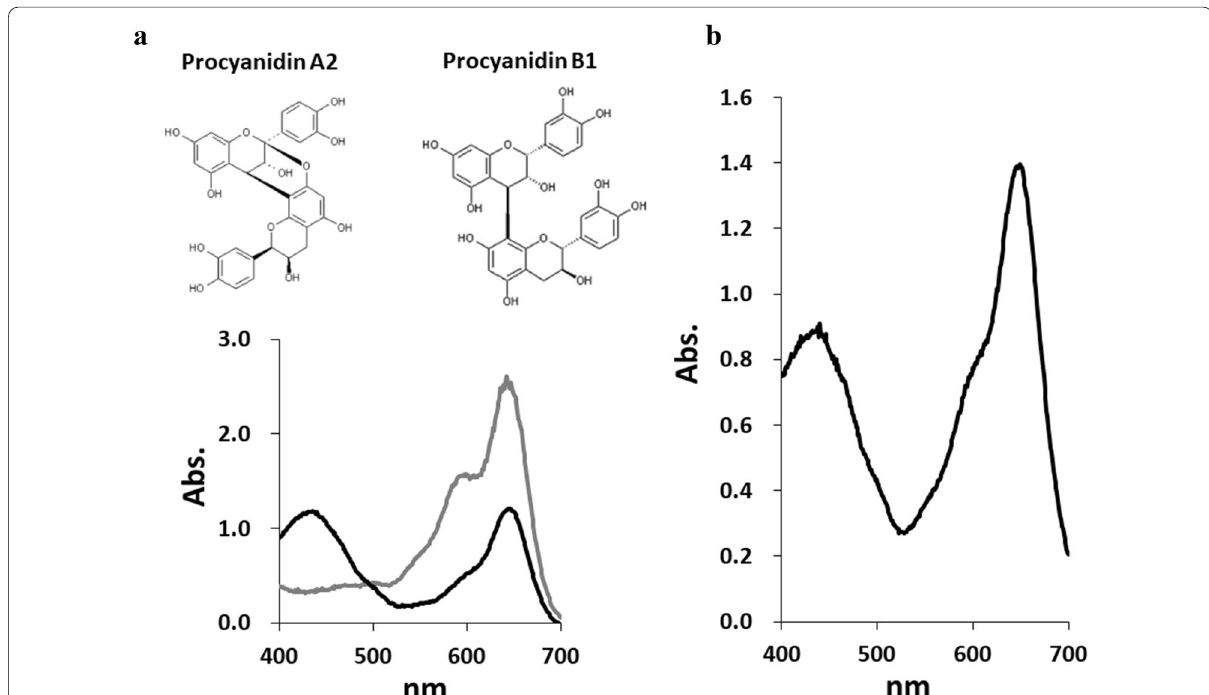
Fig. 4 Visible spectra of procyanidins and the purified sample from A. zerumbet aqueous extracts. a Chemical structure of procyanidins A2 and B1 (upper), the spectra of procyanidin A2 (gray line) and procyanidin B1 (black line), determined using the DMAC assay (lower). b The spectrum of the purified sample from the aqueous extract of A. zerumbet , obtained using the assay